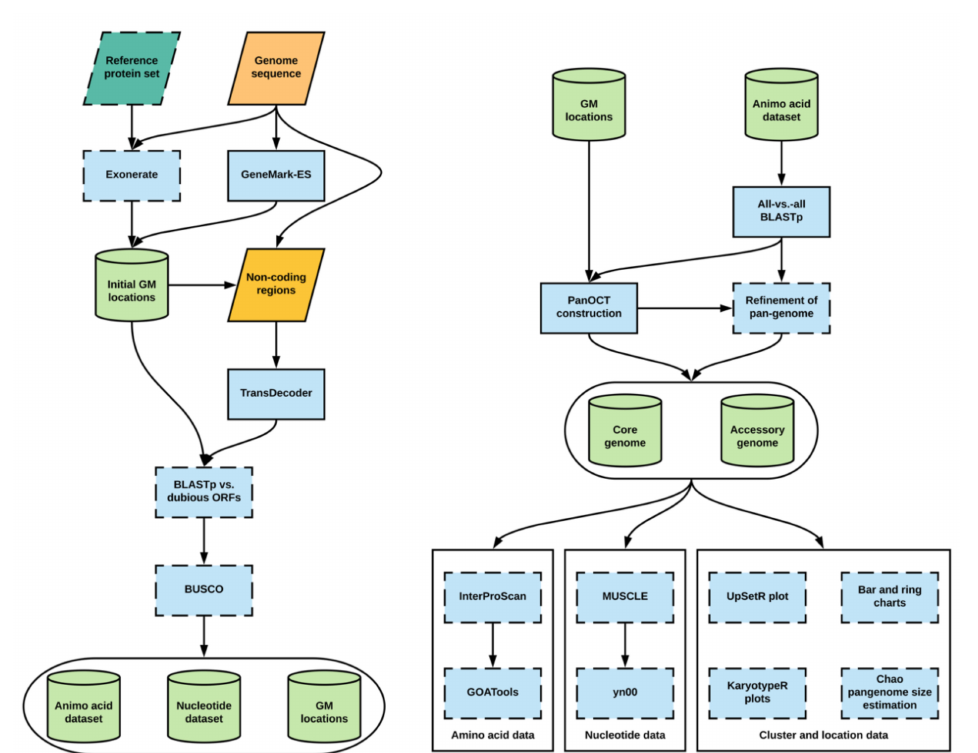
Figure 1. Workflow of Pangloss. Optional analyses represented with dotted borders. Refer to implementation for further information. GM: Gene